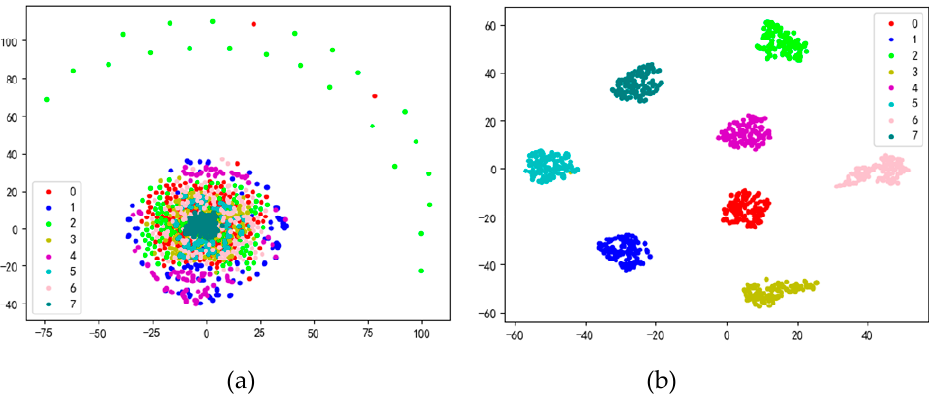
Figure 14. Feature visualization of compound fault: ( a ) the raw samples; and ( b ) the extracted fusion.